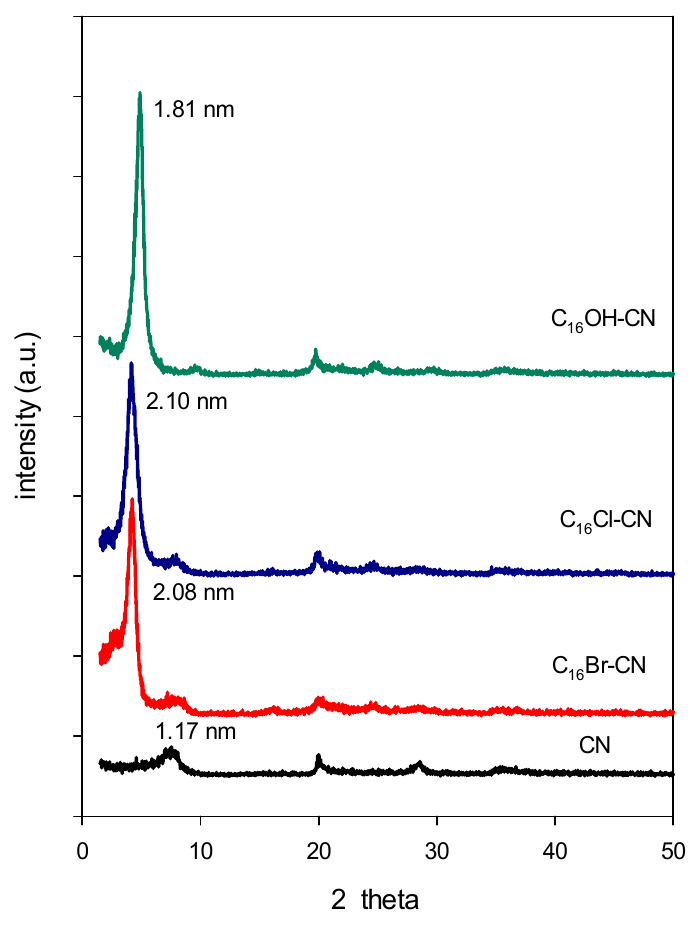
Figure 2. Powder XRD patterns of cloisite clay (CN) exchanged with di ff erent C 16 solutions.